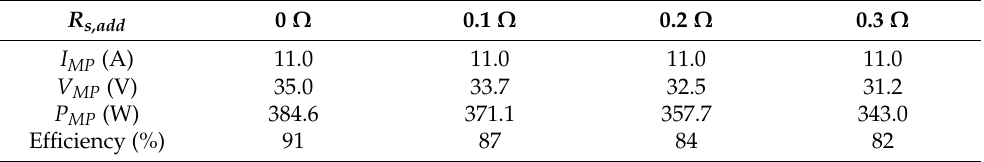
Table 3. Comparison of the PVE Efficiency According to the Value of R s,add .